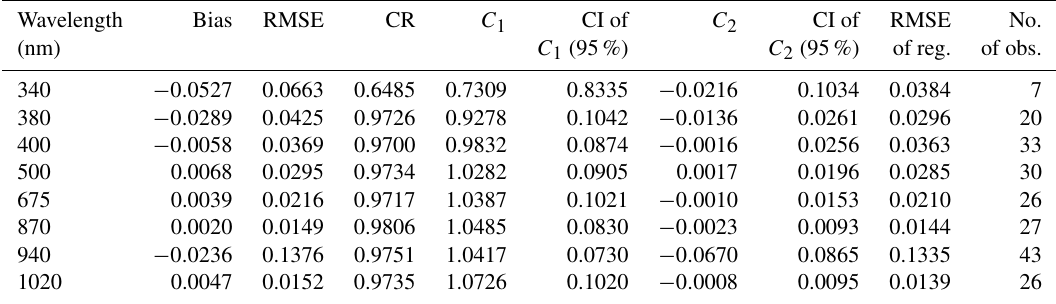
Table 8. Same as Table 4 except for GPS and corrected POM-02 precipitable water vapor. POM-02 Bias RMSE CR C 1 CI of C 2 CI of RMSE No. C 1 (95%) C 2 (95%) of reg. of obs. Sun and moon 0.0159 0.2050 0.9664 0.9032 ± 0 . 0089 0.1255 ± 0 . 0122 0.1896 Sun 0.0072 Moon 0.0391 671